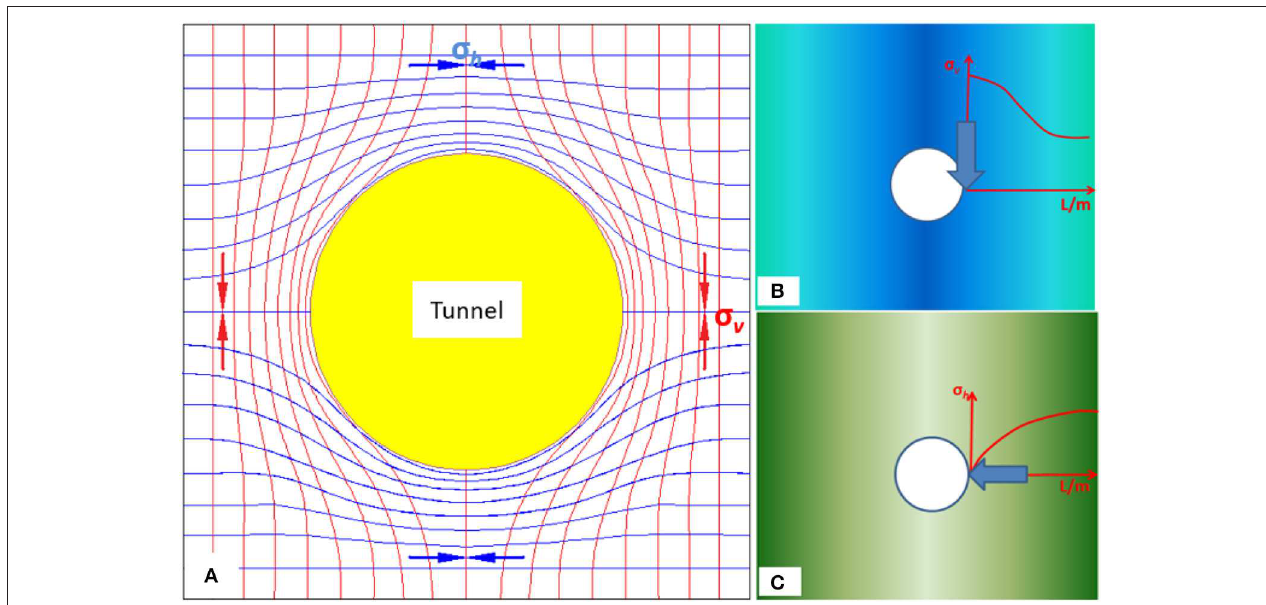
FIGURE 1 | Radial stress gradient state of rocks: (A) overall perspective; (B) vertical stress; (C) horizontal